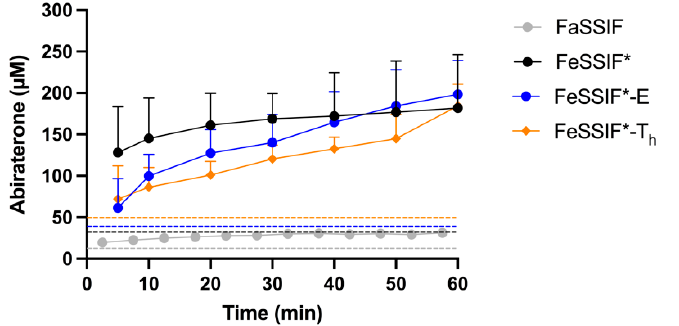
Figure 6. Abiraterone concentration-time profiles in FaSSIF, FeSSIF*, FeSSIF*-E (total) and FeSSIF*-T h (total) during rat intestinal perfusion of an abiraterone acetate suspension (0.5 mg/mL). Horizontal colored dotted lines represent the (total) apparent solubility of abiraterone in the corresponding medium, indicating abiraterone supersaturation over the course of the experiment in all media. Data represent mean ± SD (n = 3).